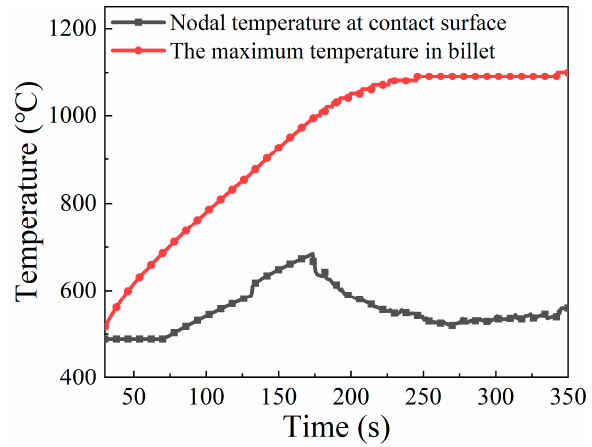
Figure 12. Evolution of the maximum temperature and the nodal temperature of contact surface over time during the primary stage of the forming process.